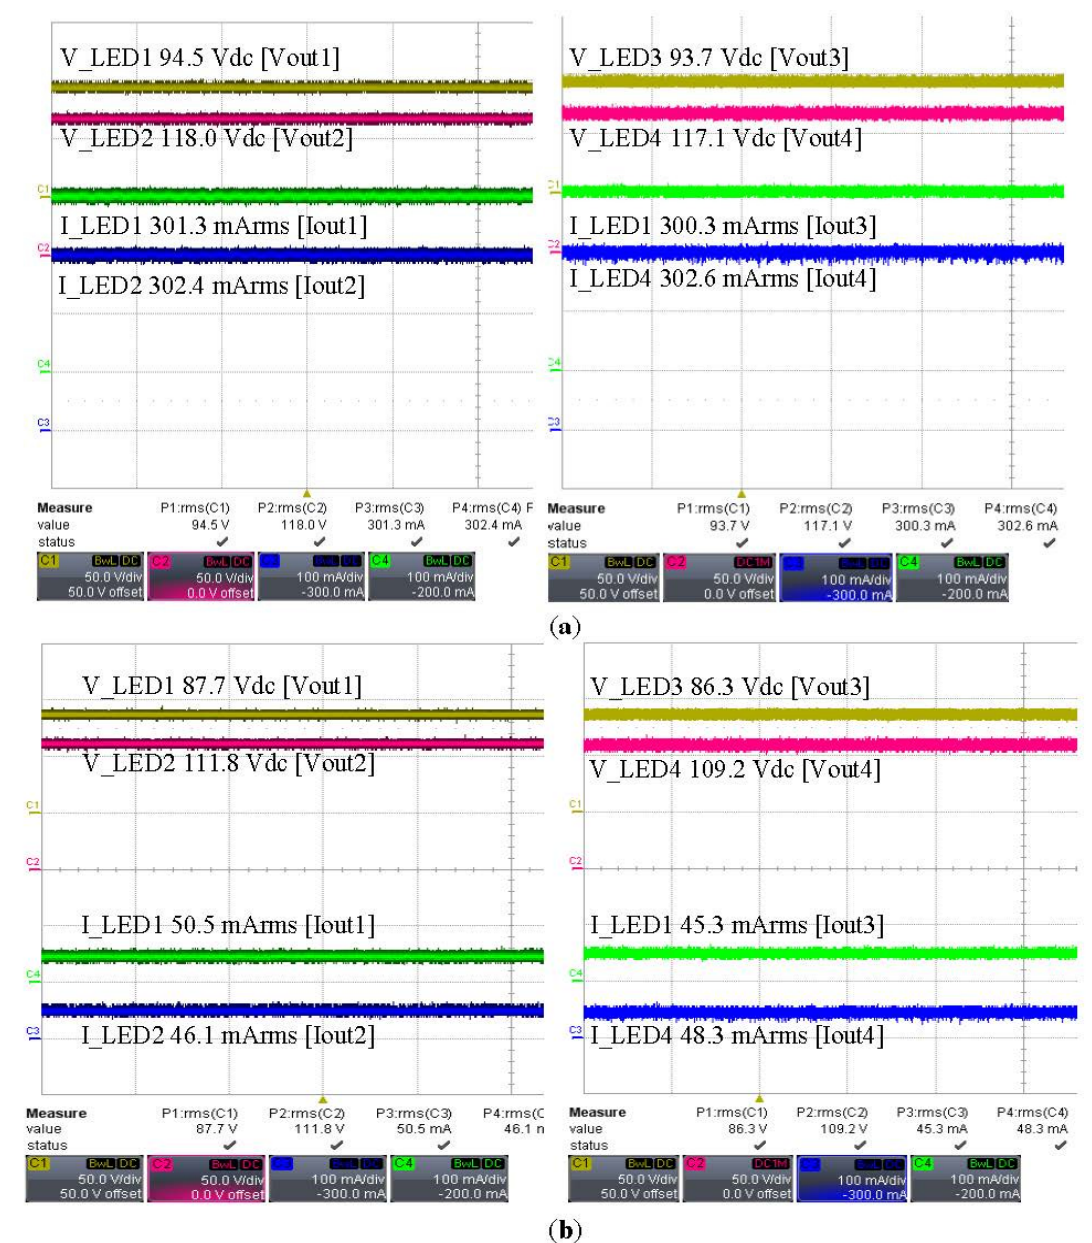
Figure 23. Output voltage-current waveform under 100% and 10% brightness condition; ( a ) Ch1~Ch4 output voltage-current waveform under 100% brightness condition; ( b ) Ch1~Ch4 output voltage-current waveform under 10% brightness